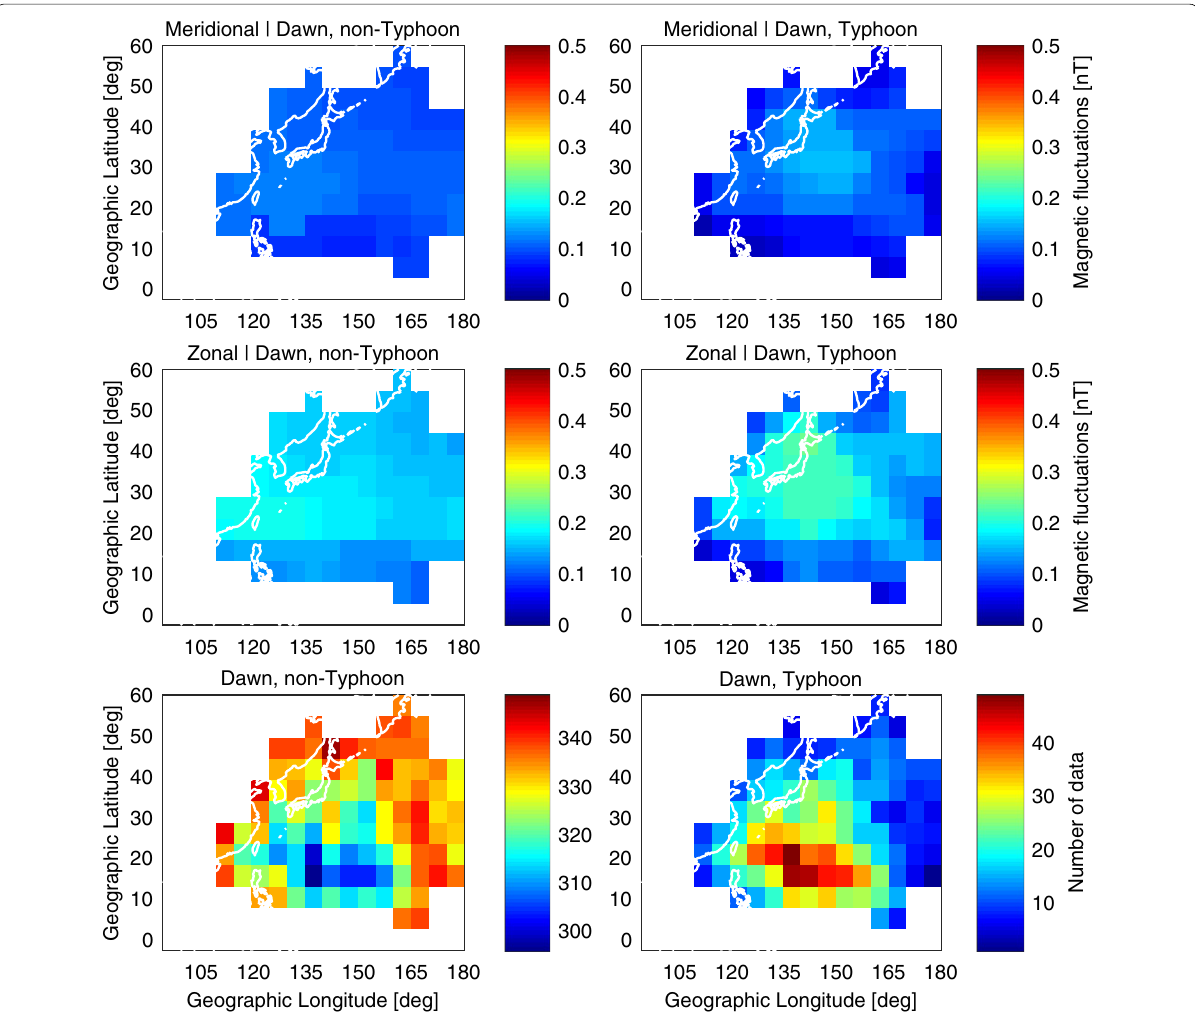
Fig. 10 Comparison of average MR amplitudes between typhoon and non-typhoon cases. The left and right panels show non-typhoon and typhoon cases on the dawn side sector (3–9 LT), respectively. Average amplitudes of the meridional ( top ) and zonal ( middle ) components, and number of data ( bottom ) in each mesh grid are